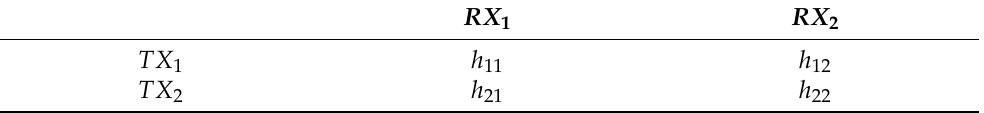
Table 1. Definition of complex channel gain between the transmit and receive